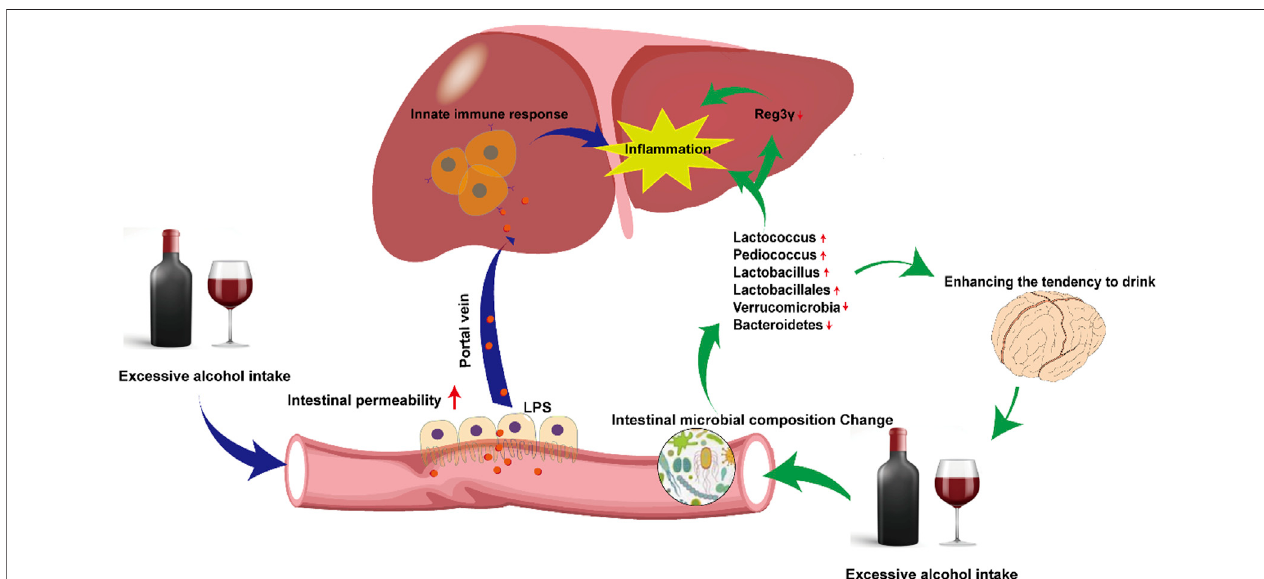
FIGURE 2 | Mechanisms of disordered intestinal microbes and intestine-liver axis on Alcoholic fatty liver. Excessive alcohol consumption alters the distribution of intestinal microbes and permeability. Changes in intestinal microbes directly cause hepatic in fl ammation, also indirectly aggravate in fl ammation by downregulating the expression of Reg3 γ . Alterations in intestinal permeability leads to more LPS entering the liver via portal vein, activating innate immunity and aggravating hepatic in fl